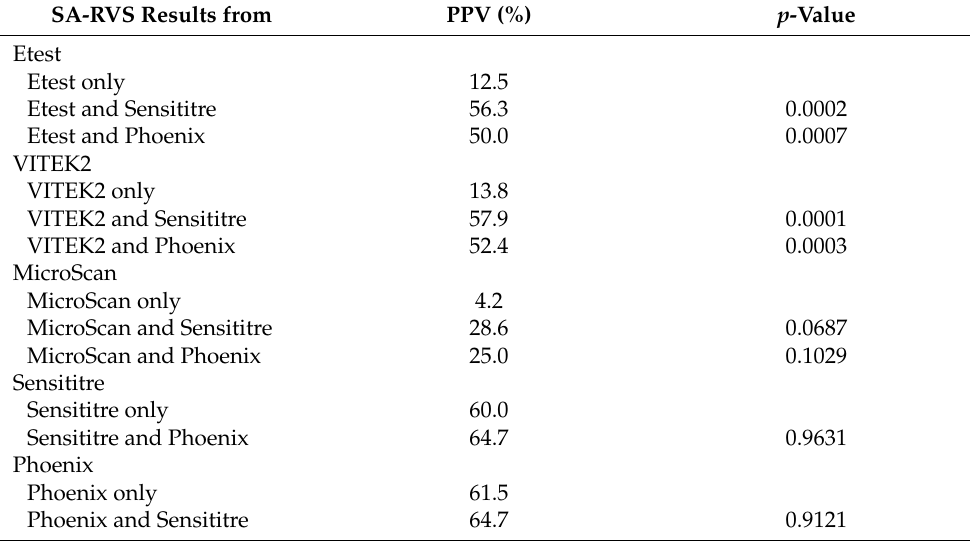
Table 5. Positive predictive value (PPV) for detecting SA-RVS of antimicrobial susceptibility testing methods when each test method and test method are